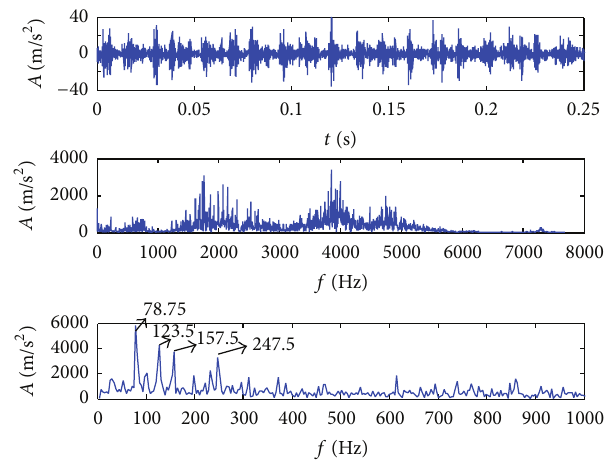
Figure 3: Signal waveform and frequency